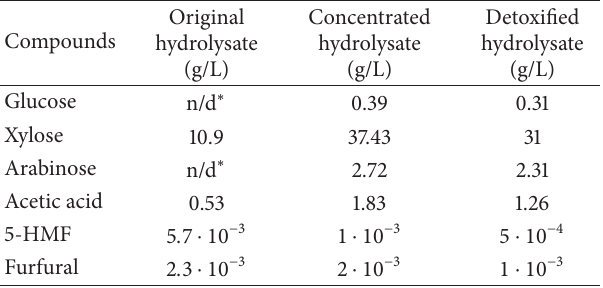
Table 2: Composition of original, concentrated, and detoxified